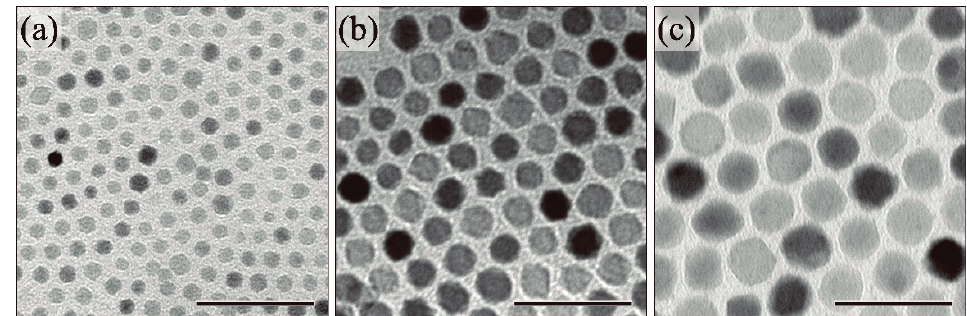
Figure 4. TEM images of ( a ) 6.6 ± 1.0 nm (1 h); ( b ) 13.0 ± 0.9 nm (3 h); and